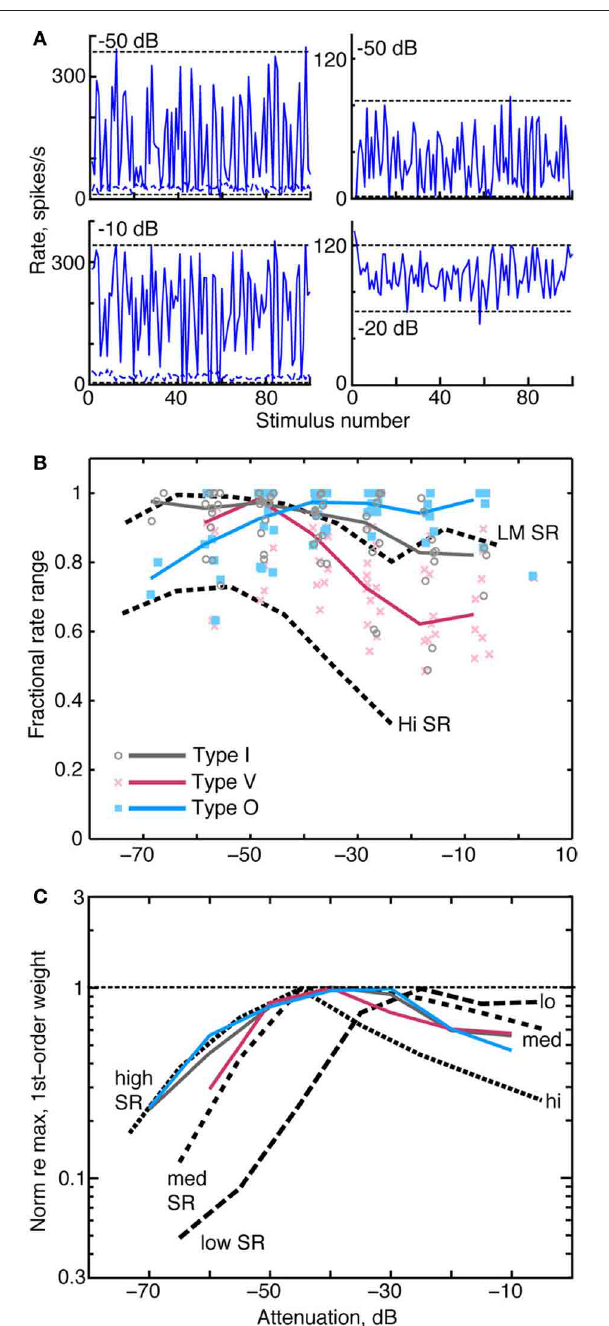
FIGURE 10 | Relationships between rate dynamic range, weight amplitude, and stimulus level. (A) Rate responses of two type I neurons to RSS stimuli. Each column contains data from one neuron, presented at two sound levels, as given by the legends. Horizontal dashed lines indicate rates at the 2.5 and 97.5 percentiles of the distribution of rates. FRR is calculated from these rates, see text. (B) FRR s of type I, O, and V populations at different attenuations of the RSS stimuli. Symbols mark the FRR of one neuron’s responses at the indicated sound level. Abscissa positions of the data points are dithered by ± 3dB to improve clarity. Solid colored lines are the median FRRs for the neuron types in 10dB bins.